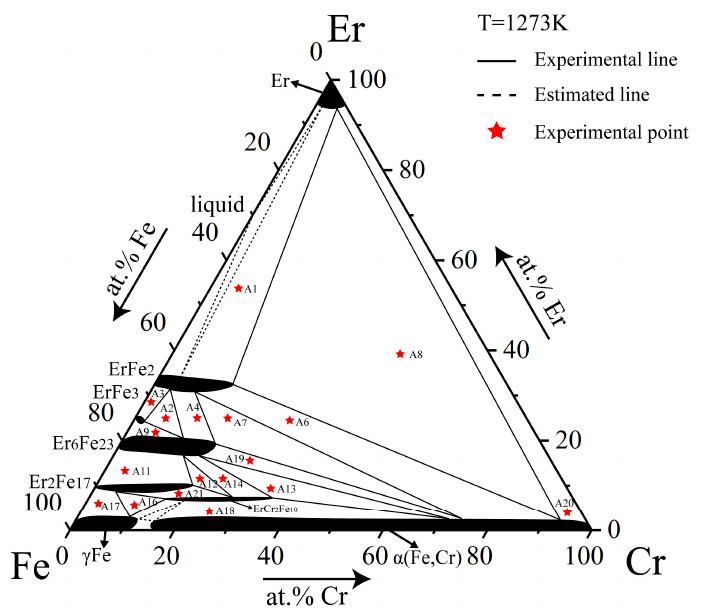
Figure 5. Isothermal section of the Fe–Cr–Er ternary system at 1273 K determined in this work. The isothermal section of the Fe–Cr–Er ternary system at 1073 K is similar to that at 1273 K, except that the maximum solid solubilities of ErCr 2 Fe 10 , ErFe 2 , ErFe 3 , Er 6 Fe 23 , Er 2 Fe 17 , and Er are slightly lower. Additionally, α (Fe,Cr) appears at the Fe-enriched corner instead of γ (Fe) at 1073 K. This is consistent with the binary optimized phase diagram, and therefore its appearance is reasonable and in accordance with expectation [31]. The 1073 K isothermal section obtained in this work is shown in Figure 6.